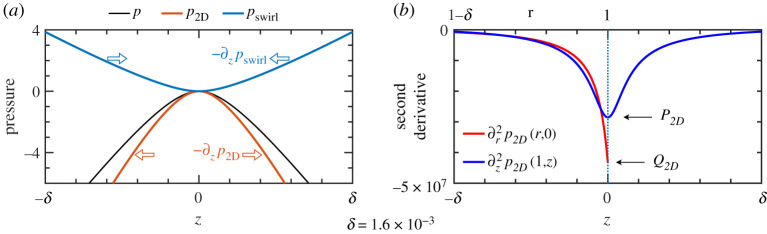
(a) Pressure components from figure 3 plotted as function of z along the cylinder wall (r = 1). Arbitrary constants are such that fields are all zero at z = 0. The meridional pressure p2D has negative curvature (local maximum) and hence −∂zp2D is an adverse pressure gradient directed outward from the critical ring (open red arrows). The axial curvature of the swirl pressure pswirl is positive and hence −∂zpswirl is a favourable pressure gradient directed toward the critical ring (open blue arrows). The full pressure field p = p2D + pswirl has a local maximum, but with less axial curvature than p2D, and hence a weaker adverse pressure gradient (not indicated), than p2D near the critical ring. (b) Second derivatives of p2D along one-dimensional slices: ∂r2p2D on the midplane and ∂z2p2D on the cylinder wall. The dotted line indicates the critical ring in both cases, where the second derivatives give the pressure curvatures P2D and Q2D. (Numerical values for the curvatures are given in table 1.) The near symmetry of p2D in the radial and axial directions does not hold on the critical ring where |P2D| < |Q2D|. (Online version in colour.)